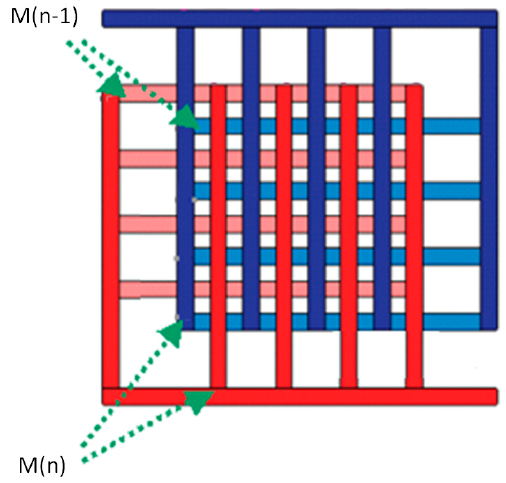
Figure 14. Schematic of the on-chip metal-oxide-metal capacitor (M presents the layer of the overlapping fingers).